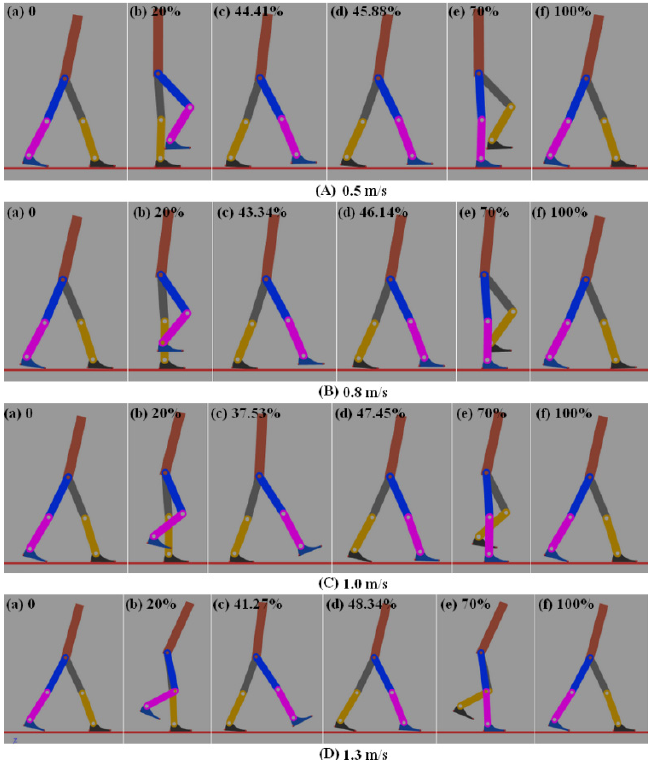
Figure 11. Snapshots of the simulated bipedal robot. ( A ) 0.5 m/s ( B ) 0.8 m/s ( C ) 1.0 m/s ( D ) 1.3